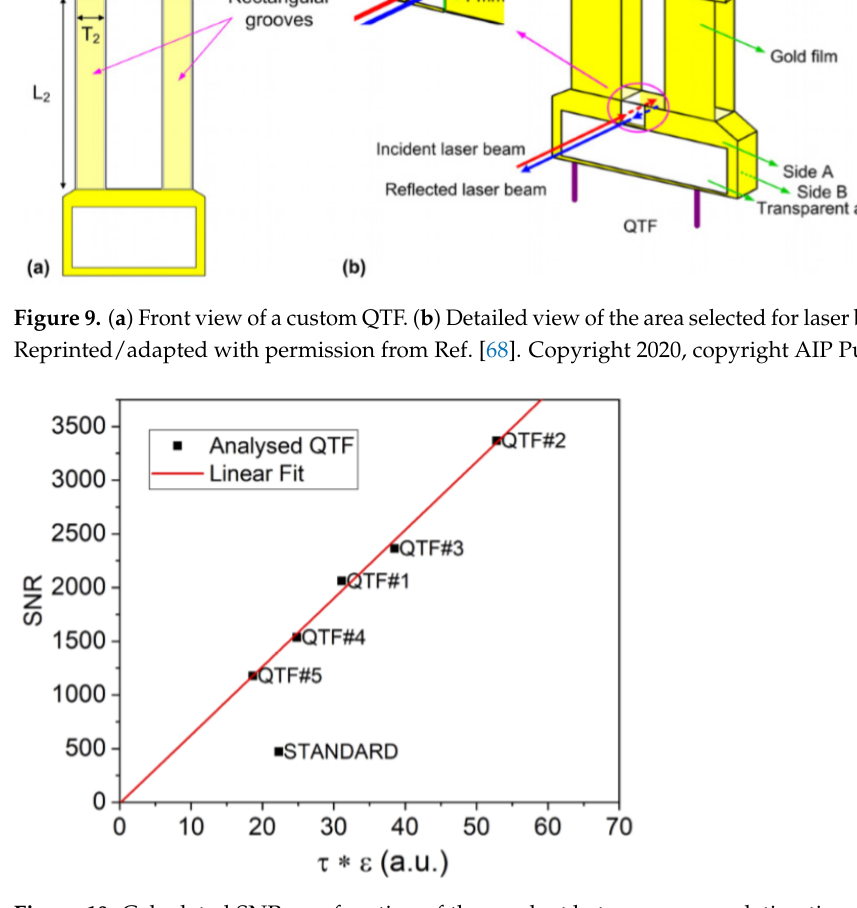
Figure 9. ( a ) Front view of a custom QTF. ( b ) Detailed view of the area selected for laser beam fo- cusing. Reprinted/adapted with permission from Ref. [68]. Copyright 2020, copyright AIP Pub- lishing. Table 1. The characteristic parameters of the used six QTFs. f : measured resonance frequency of the fundamental mode; Q -factor: related quality factor; τ : accumulation time; ε : maximum strain field. Reproduced with permission from Ref. [127]. Copyright 2020, copyright The Optical Society.